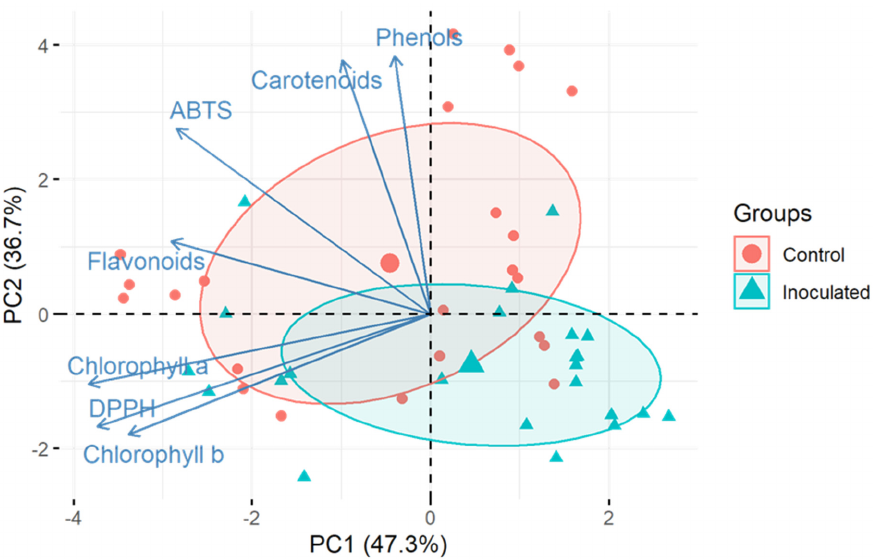
Figure 3. Concentration of tested metabolic and physiological parameters throughout the experiment via principal component analysis (PCA) displaying the main principal components (PCs), which represent 84.41% of cumulative variance. Loading vectors show the correlation between tested variables.